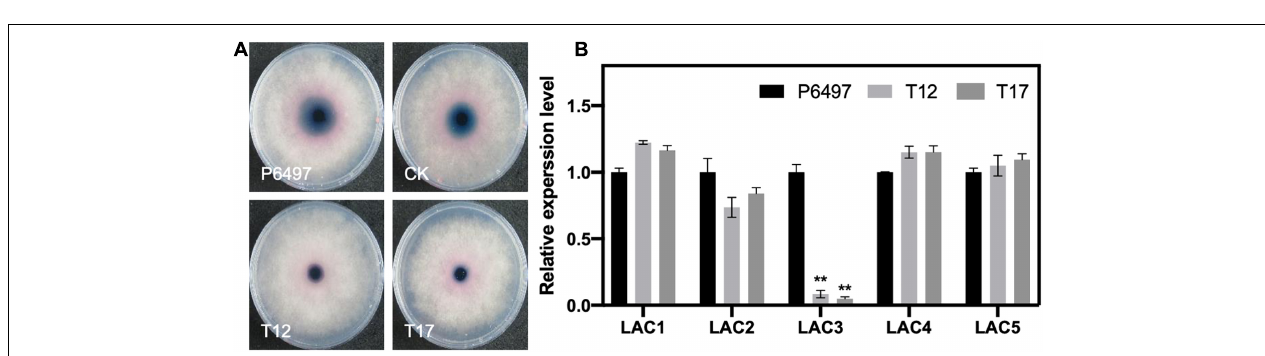
FIGURE 7 | Detection of laccase activity and the relative expression of putative laccase-encoding genes in the PsGRASP -knockout mutants. (A) Mycelial mats of P6497, CK, T12, and T17 were inoculated on LBA media containing 0.2 mM ABTS and grown for 7 days. The oxidized ABTS (dark purple) was measured as an index of laccase activity. (B) qRT-PCR analysis of five highly expressed laccase-encoding genes ( PsLAC1-5 ) in P6497, T12, and T17. Three biological replicates were performed. Error bars denote SD. ** P < 0.01, Student’s t